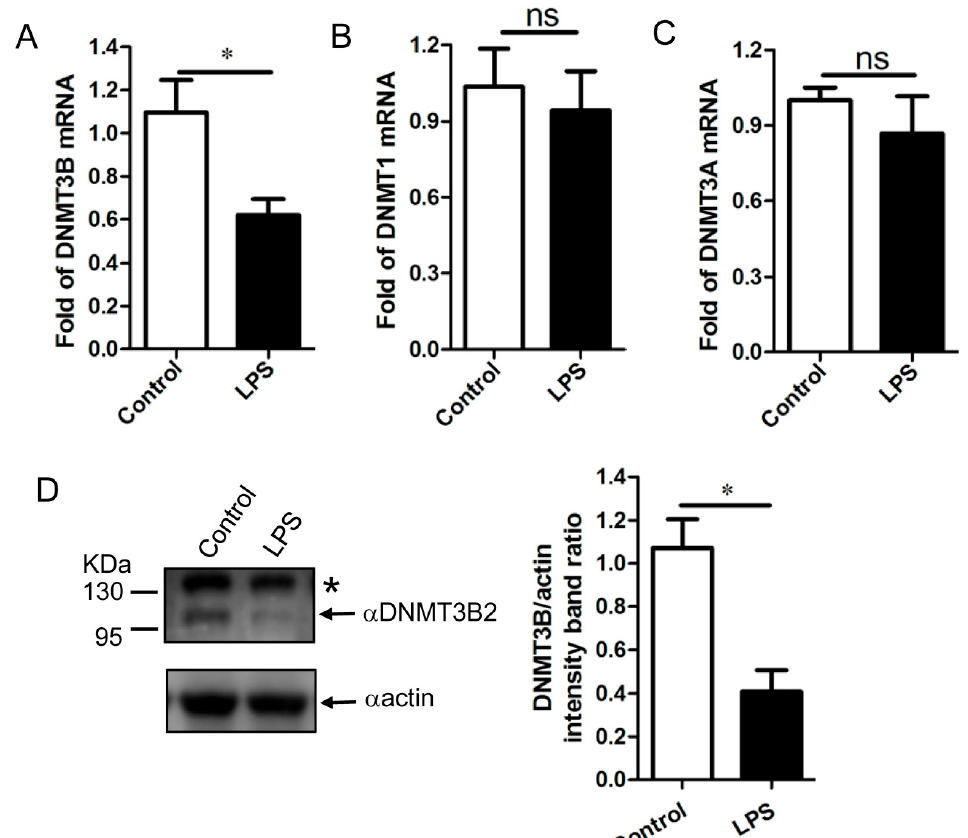
Figure 4. Total RNA was extracted from the treated and untreated PAM by LPS and expression of DNMT3B, DNMT1, and DNMT3A was analyzed by qRT-PCR analysis. The relative expression of DNMT3B ( A ), DNMT1 ( B ), and DNMT3A ( C ) was calculated as per material and method. n = 3, the data shown are mean (SD), ns is representative of no significant difference between control and LPS stimulated groups, *, p < 0.05. ( D ) PAM with or without LPS treatment was harvested and analyzed by Western blot with anti-pDNMT3B antibody. Note that LPS stimulation decreased expression of DNMT3B2 in comparison to control group. The representative bar graph was calculated by DNMT3B2/actin ration. The data shown are mean (SD) ( n = 3), *, p < 0.05.